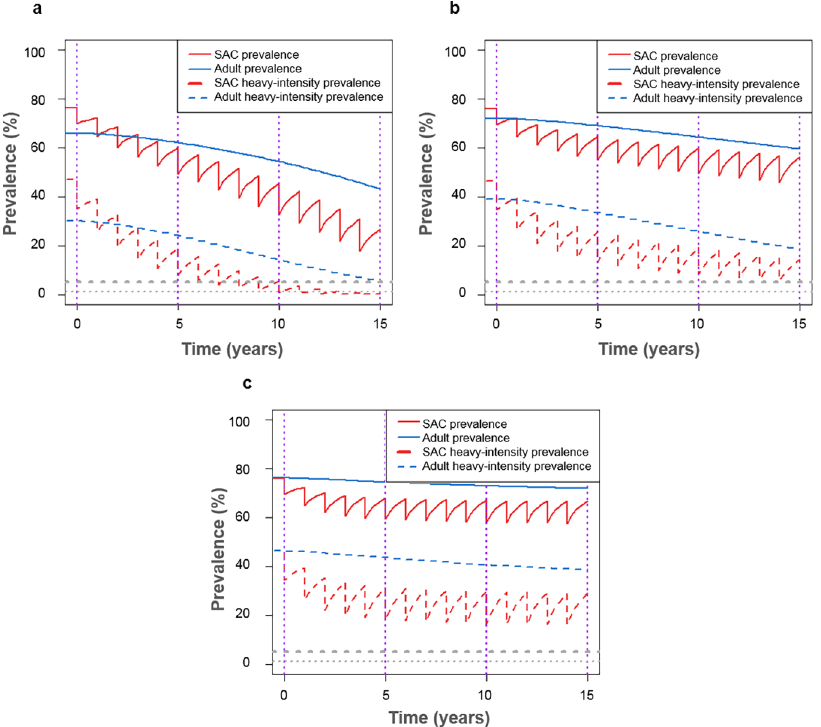
Fig 3. Model projections of annual treatment of 75% school-aged children (SAC; 5–14 years of age) and 0% adults (15+ years of age). Shown for high prevalence settings ( (cid:21) 50% SAC baseline prevalence) for (a) low (R 0 = 3.0), (b) moderate (R 0 = 3.5) and (c) high (R 0 = 4.0) adult burdens of